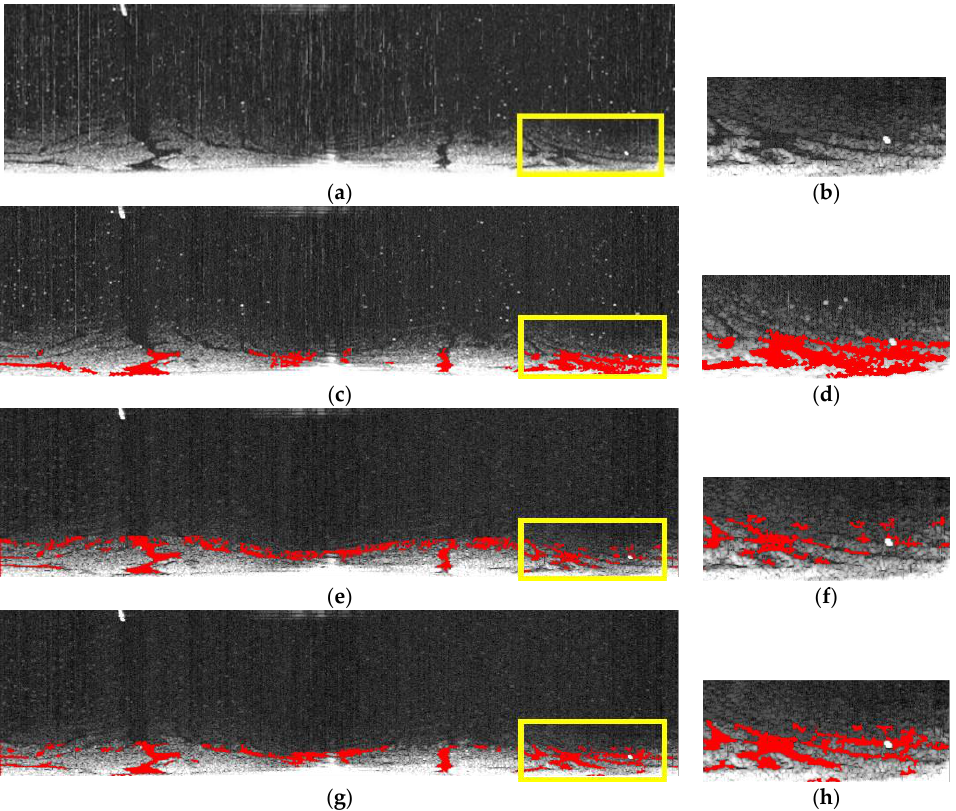
Figure 15. Comparing three methods in extracting oil spills: ( a ) original image; ( b ) enlarged version of the highlighted area in ( a ); ( c ) oil spill detected using the method proposed by Zhu et al.; ( d ) enlarged version of the highlighted area in ( c ); ( e ) oil spill detected using the method proposed by Bradley et al.; ( f ) enlarged version of the highlighted area in ( e ); ( g ) oil spill detected using the improved adaptive enhancement; and ( h ) the enlarged version of the highlighted area in ( g ).